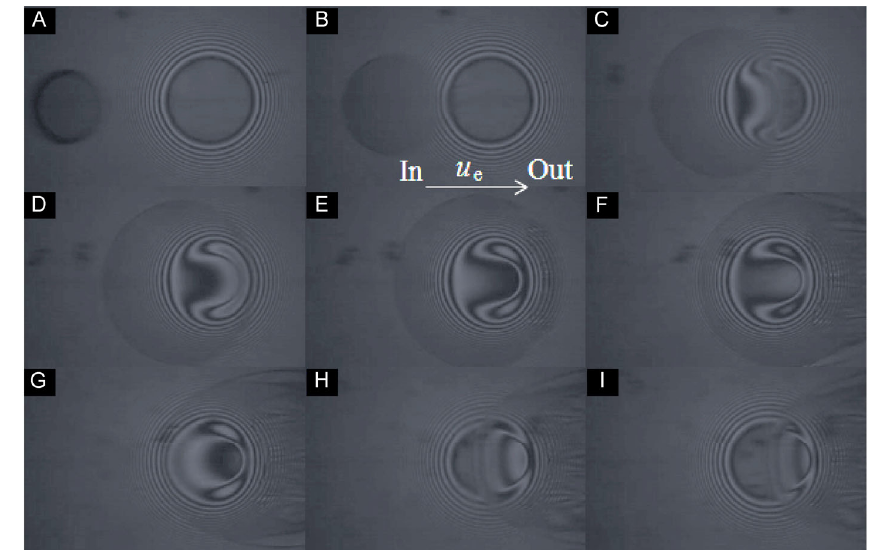
Fig. 12 Interferograms of droplet passing through the rolling contact, PAO100, u e = 95.1 mm/s, w = 30 N, D ini = 274 μ